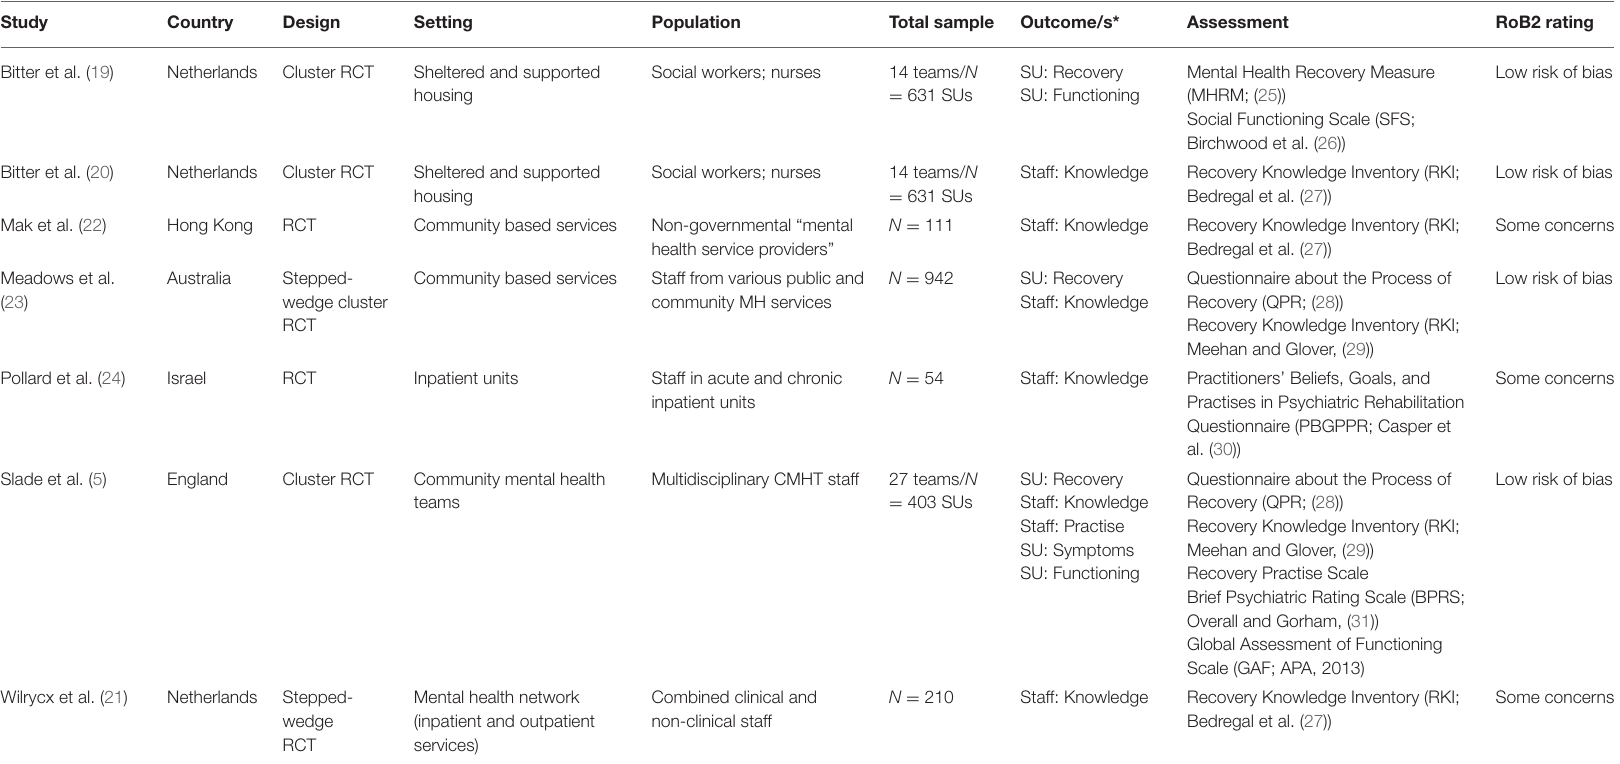
TABLE 1 | Details of included